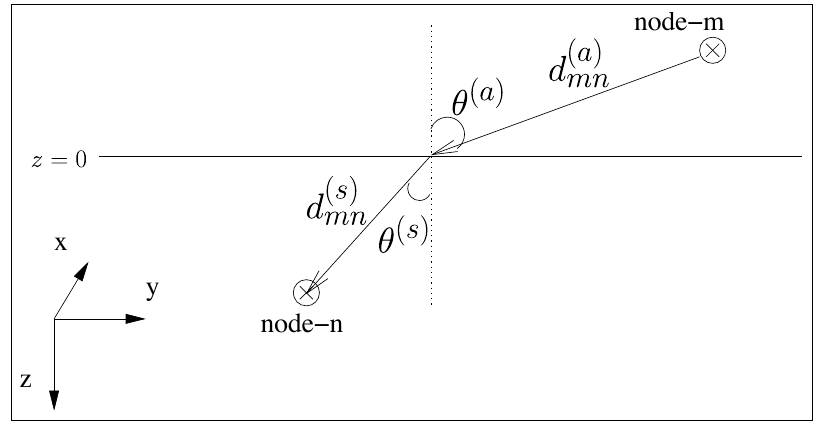
Figure 2. Air-node to soil-node communication between two nodes m and n